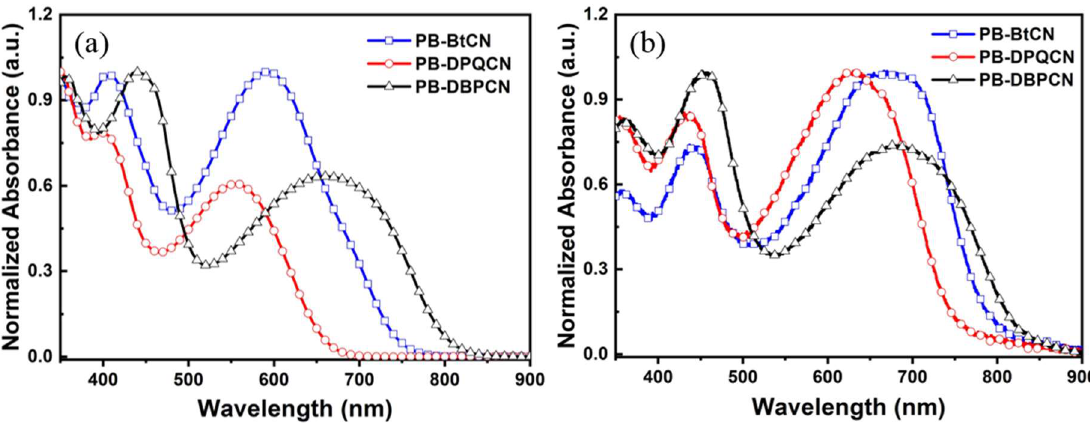
Figure 3. UV–Vis spectra of PB-BtCN, PB-DPQCN, and PB-DBPCN ( a ) in chloroform solution and ( b ) in thin films (as for film sample, spectra are offset for clarity).